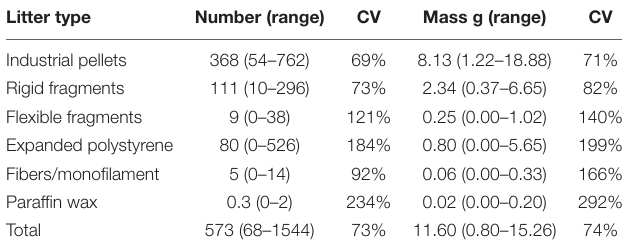
TABLE 3 | The mean abundance and mass of meso-litter (2–10 mm) per meter of beach in the West Coast National Park, South Africa, based on 12 0.5-m transects sampling the top 5 cm of sand in 2010 ( n = 8), 2015 (1) and 2017